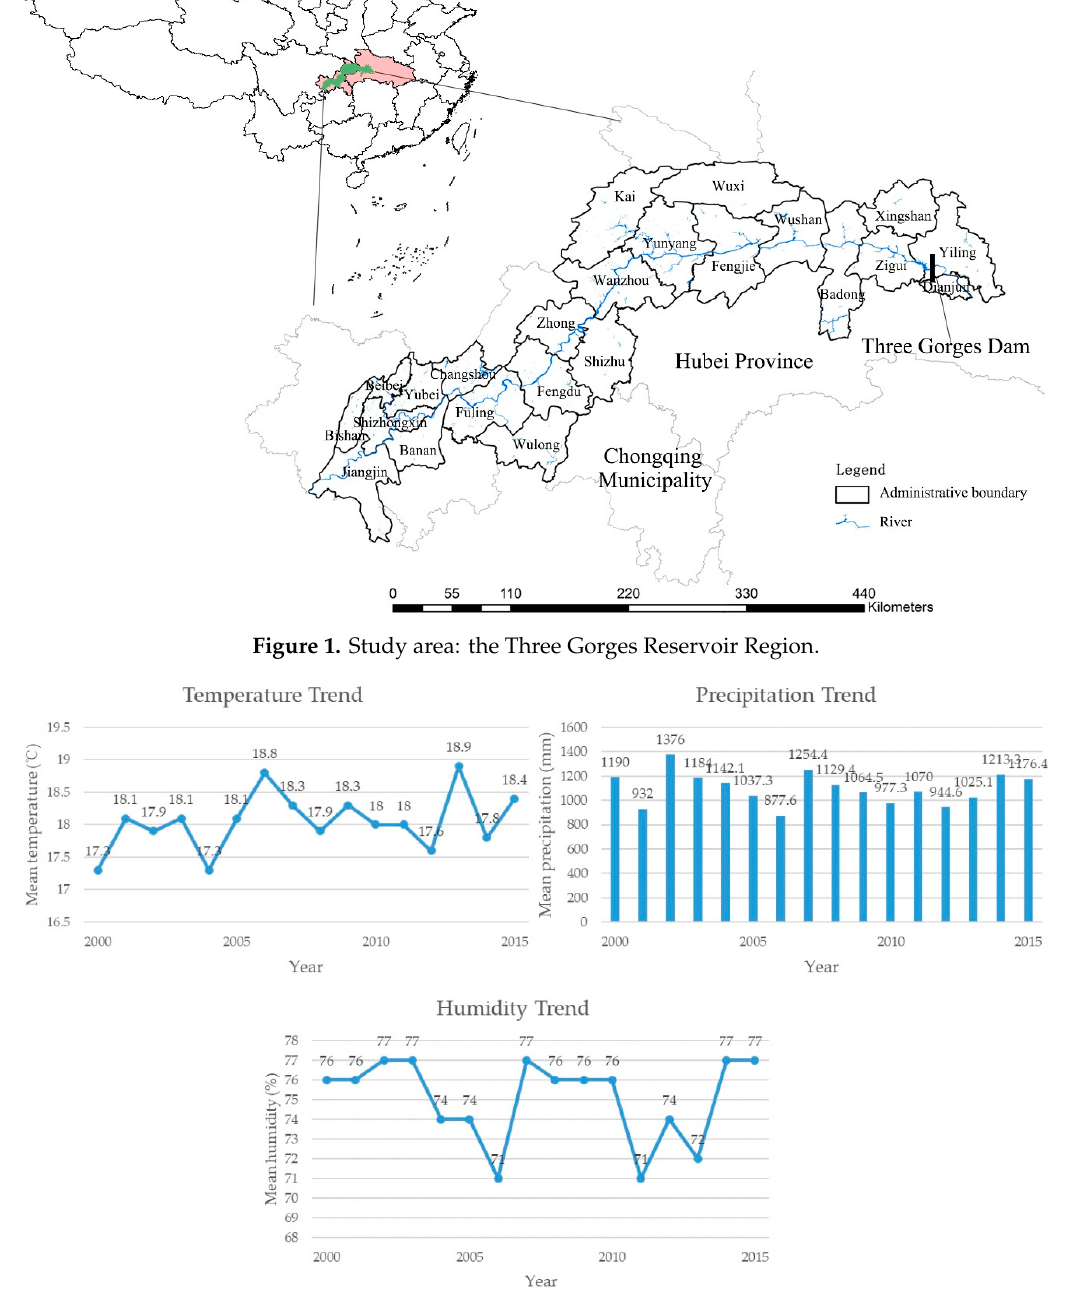
Figure 2. Temperature, precipitation and humidity trends from 2000 to 2015 in the TGRR.